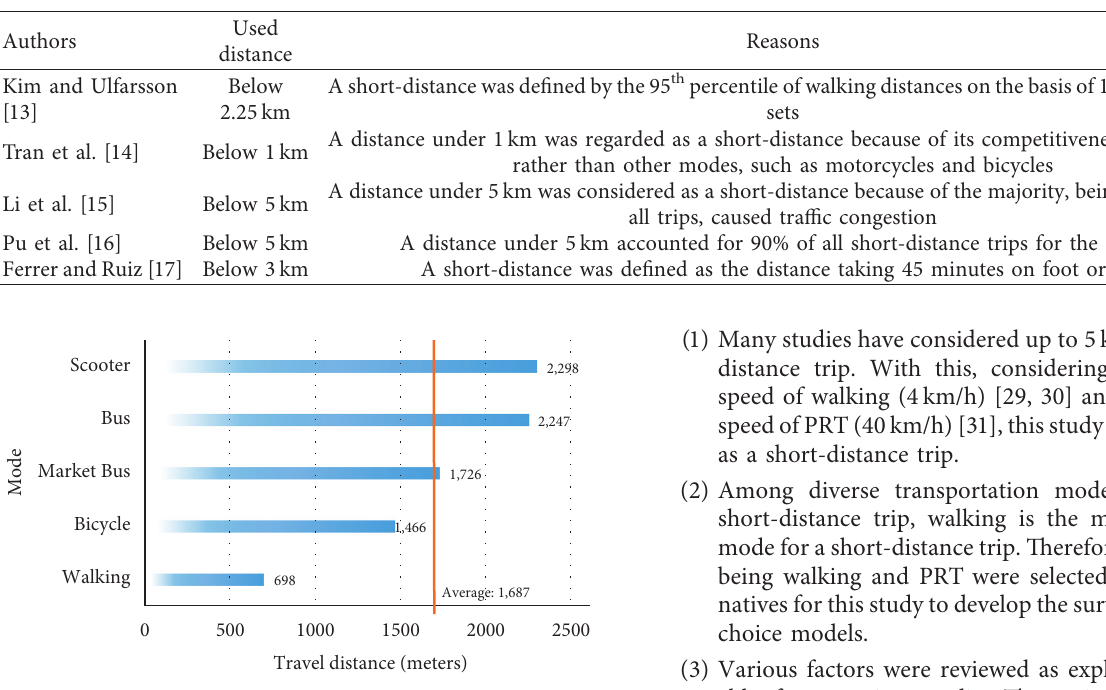
Table 1: A comparison of definitions used for a short-distance trip.